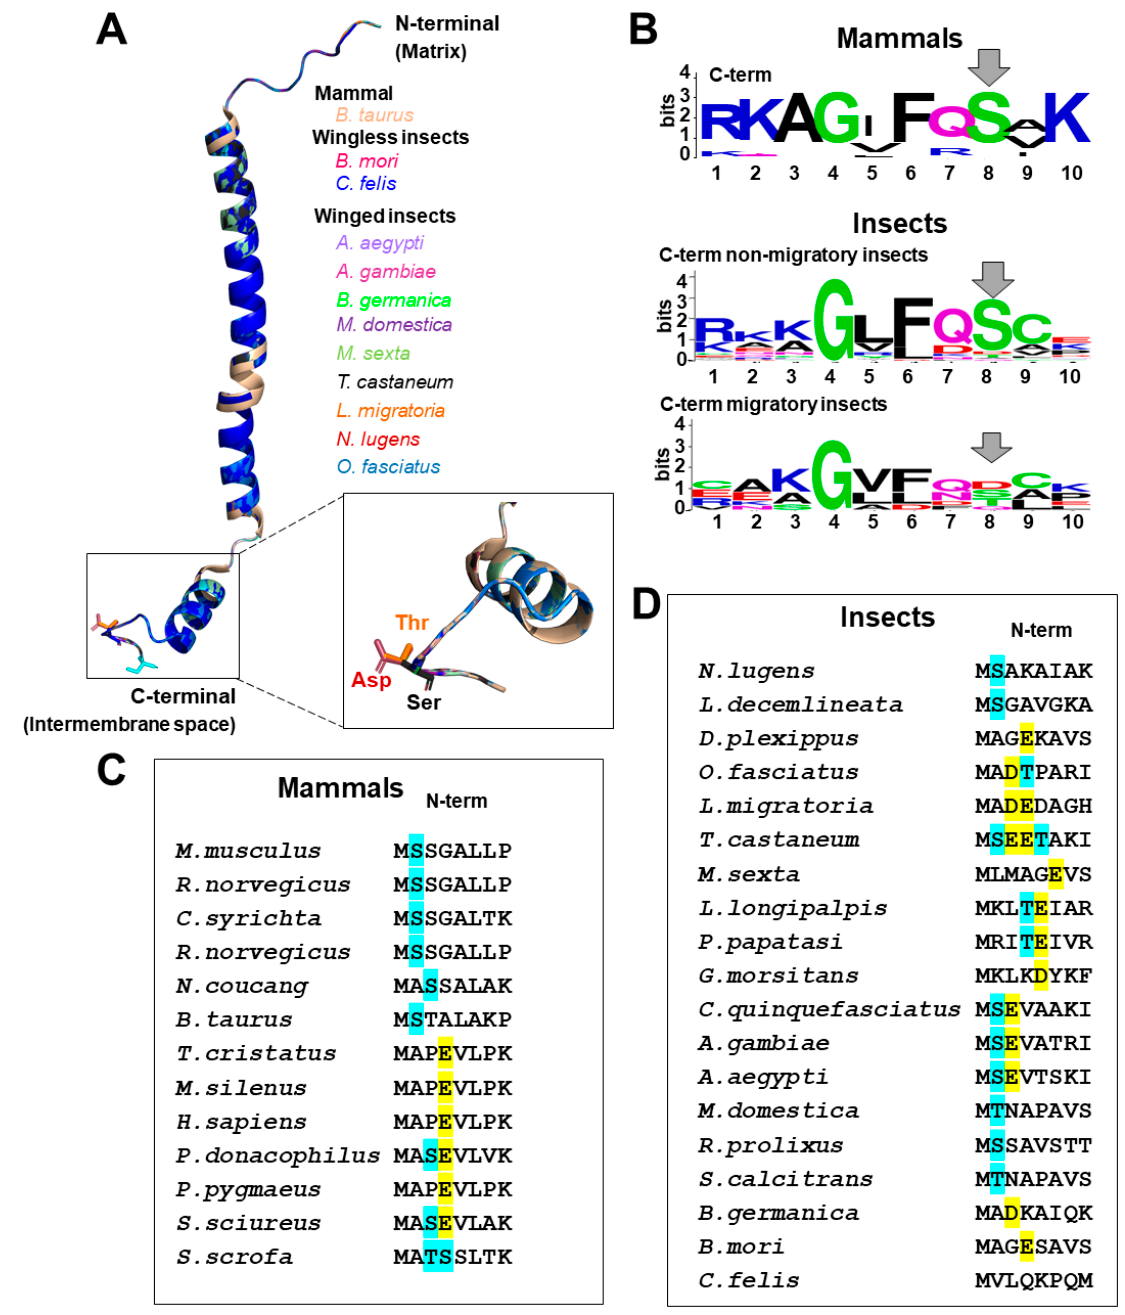
Figure 4. The tridimensional structure models of COXVIc in insects: ( A ) overlay of structure models of COXVIc from 11 insect species modeled in the Phyre 2 server using the primary sequence as input, normal modeling mode and the B. taurus crystal structure (PDB: 1V54) as a template [171]. All structures were aligned from the mitochondrial matrix N-terminal on the top to the C-terminal at the intermembrane space at the bottom. The structure models were analyzed using Pymol software and colored as shown in the figure. The conserved Ser residue at C-terminal is highlighted and shown in the box. Remarkably, the migratory insect species ( L. migratoria and N. lugens ) have a Thr or Asp instead of Ser residue, respectively. ( B ) WebLogo of a C-terminal region of mammals (top panel), nonmigratory insects (middle panel), and migratory insects (bottom panel). The WebLogo position 8 shows the conserved Ser for mammals (position 71 at B. taurus 1V54) and nonmigratory insects, while migratory insects also have Thr and Asp residues. The N-terminal of mammalian ( C ) and insects ( D ) COXVIc demonstrate the abundance of Ser and Thr with predicted phosphorylation sites (cyan) together with the phosphomimetic Asp or Glu (yellow).